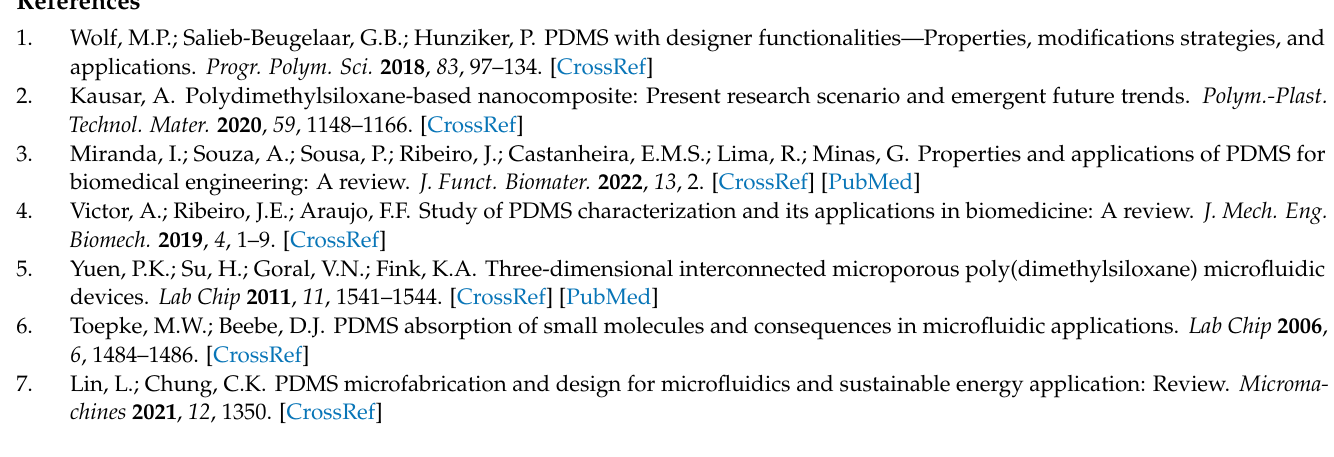
anions; Figure S2: Mean square displacement of ionically functionalized PDMS melts. Figure S3: Apparent transference